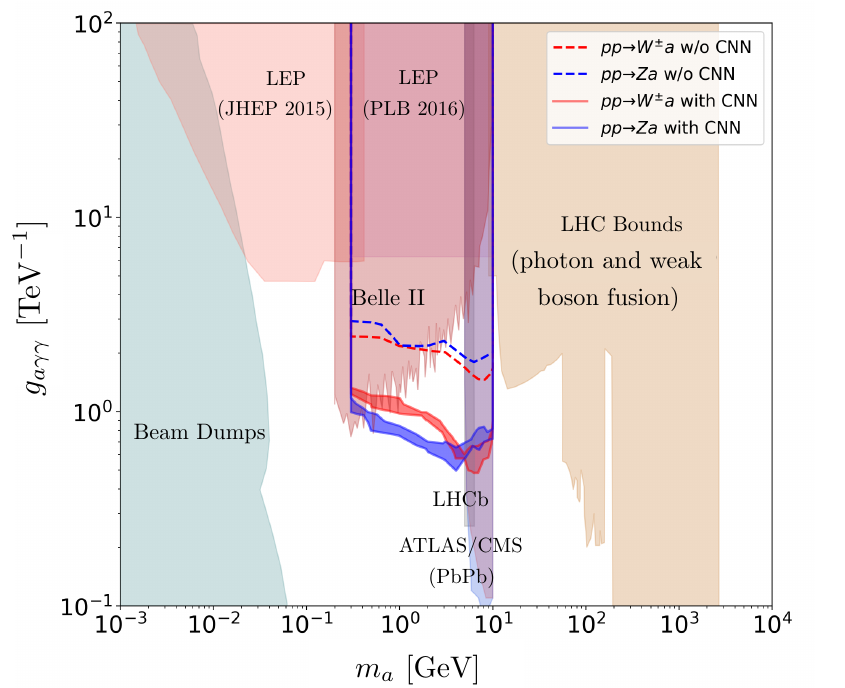
Figure 10 . The 2 σ bounds on the ALP-photon coupling g aγγ versus m a plane. Regions above the red and blue dashed lines are excluded by pp → W ± /Za at the 14 TeV LHC with an integrated luminosity 3000 fb − 1 , without using CNN [53]. Regions above red and blue bands are excluded by this work using CNN. Other bounds shown are from LEP [17, 28], L3 [100], Belle II [49], LHCb [101], ATLAS/CMS [18, 28, 96, 97], ATLAS/CMS(PbPb) [29] and Beam Dumps